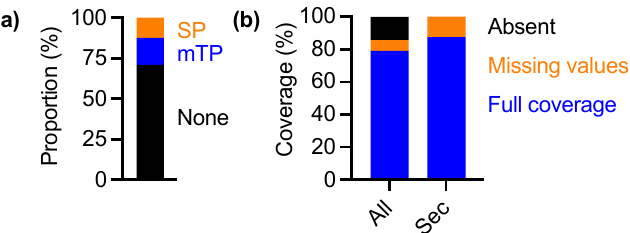
Figure 1. Proteome coverage of the selenoproteome: ( a ) Proportion of selenoproteome predicted to have a transit peptide for the secretory pathway (SP), mitochondrion (mTP), or no transit peptide (None). ( b ) Coverage of proteins containing a selenocysteine (Sec) versus the whole proteome (All) in [23]. ‘Absent’ refers to proteins that were not quantified at any of the timepoints in either the LD or LL time series. ‘Missing values’ refers to proteins that were quantified in some but not all data points of the time series, while ‘Full coverage’ refers to those proteins that were reliably quantified at every timepoint throughout the LD and LL time series. We previously published detailed proteomic time series in Ostreococcus tauri under natural cycles of light and dark (LD; 12 h/12 h cycles of light/dark), as well as under constant light conditions (LL), sampling at 3.5 h intervals [23]. In that study, we obtained 85% coverage of the theoretical proteome and, interestingly, all 24 selenoproteins were detected in the dataset (Figure 1b and Supplementary Table S1). A total of 21 out of 24